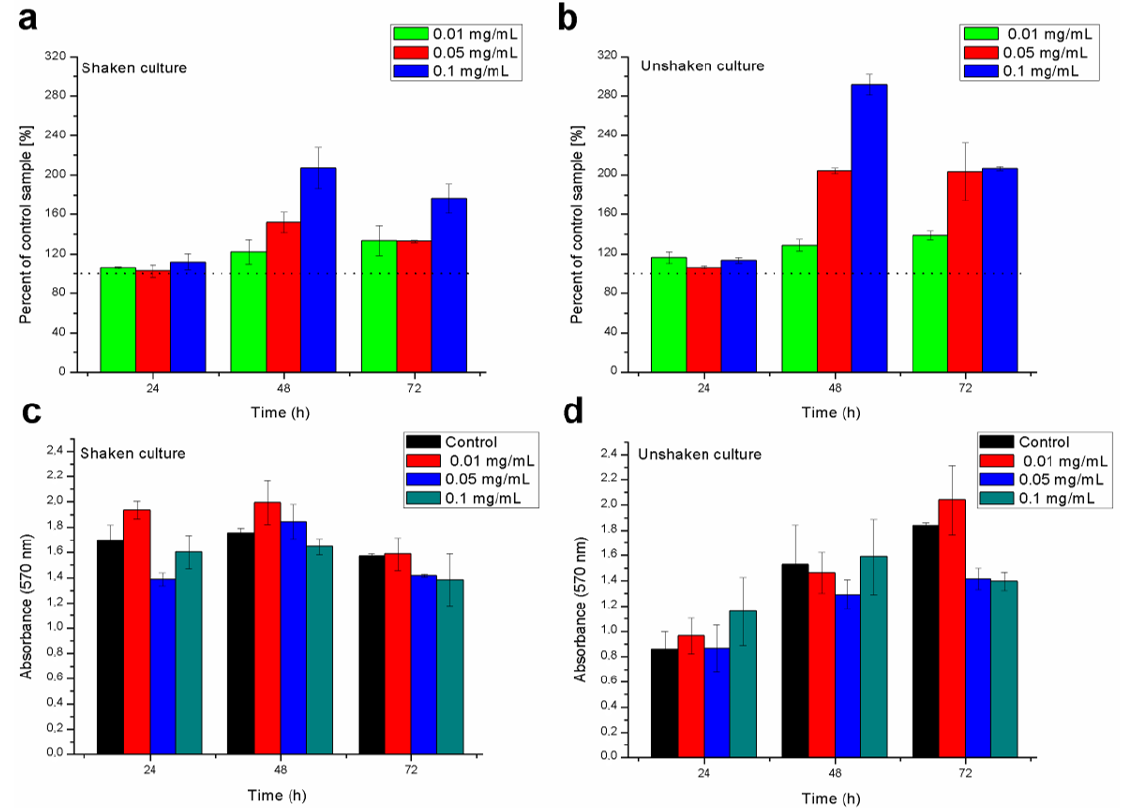
Figure 5. Viability ( a , b ) and biomass ( c , d ) of biofilms formed by P. aeruginosa PAO1 with and without the presence of titanium dioxide / silica nanotubes compared between shaken ( a , c ) and unshaken ( b , d ) cultures; nanomaterials were used in three concentrations—0.01, 0.05, and 0.1 mg / mL; bars sharing letters are di ff erent at P < 0.05, letter “a” always indicates a di ff erence with control